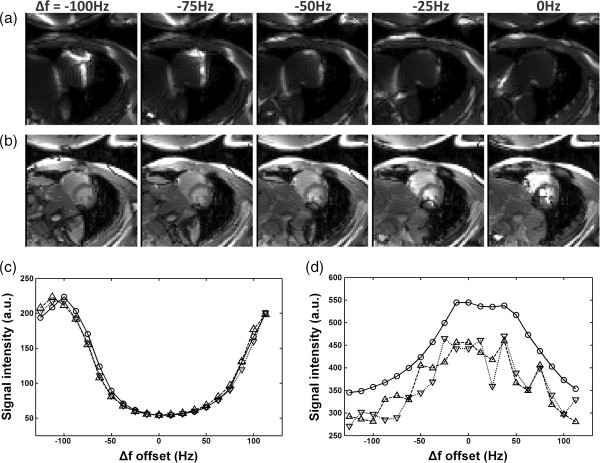
The selected images obtained using sweep scan with (a) bSSFP-L (b) bSSFP. Subfigures (c) and (d) show the ROI-averaged intensity curves acquired using the bSSFP-L sweep scan and the conventional bSSFP frequency scout (BH + ECG: circle, BH: triangle, FB: inverted triangle), respectively.